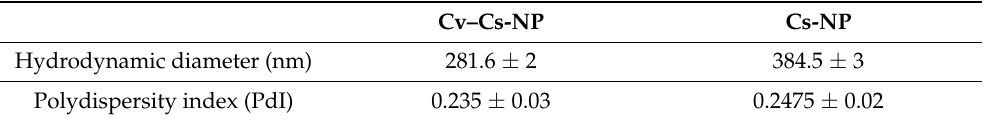
Table 2. Size and surface charge parameters of Cs-NPs and Cv–Cs-NPs in PBS buffer. Values are reported as mean ± SEM, n = 3.